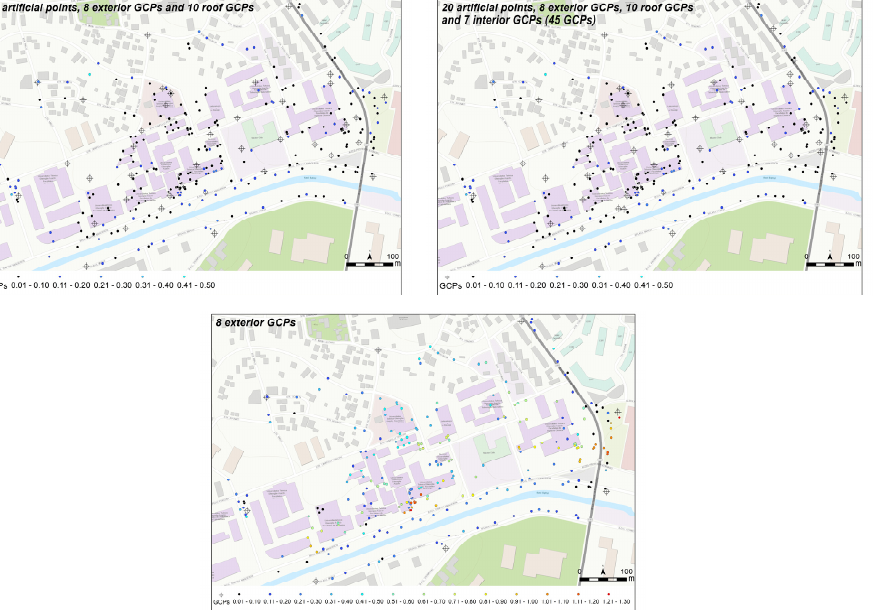
Figure A1. The spatial distribution of GCPs and ChPs and the residuals of 275 ChPs for each scenario.